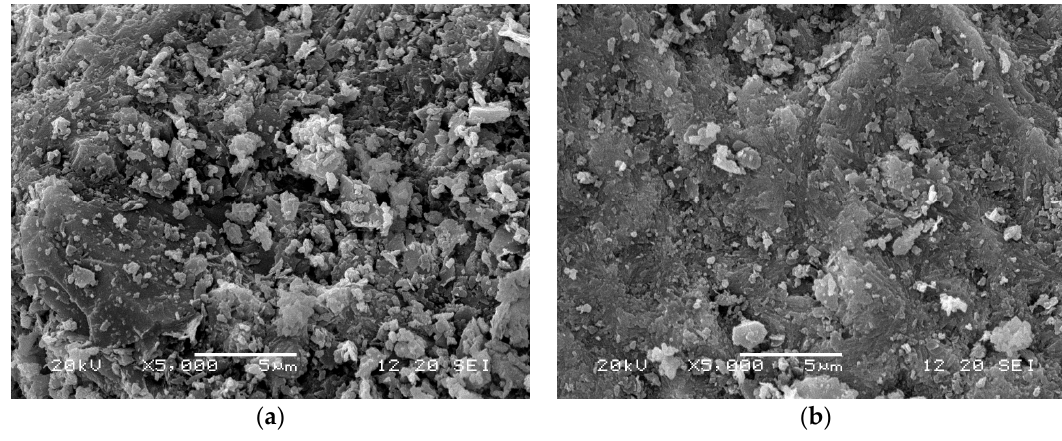
Figure 8. SEM analysis of flotation samples, ( a ) raw ore; ( b ) final concentrate.